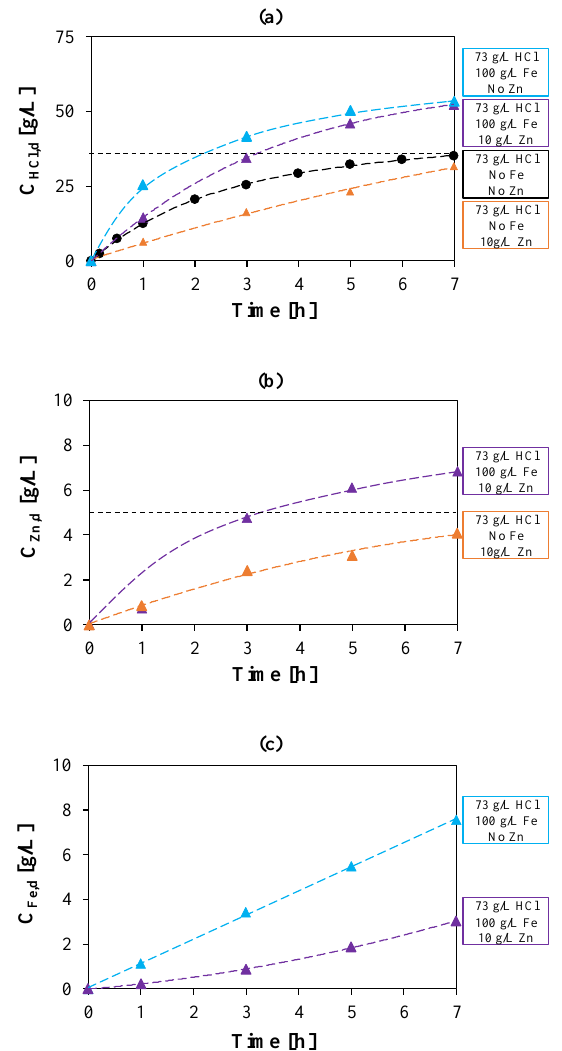
Time [h] Time [h] Time [h]